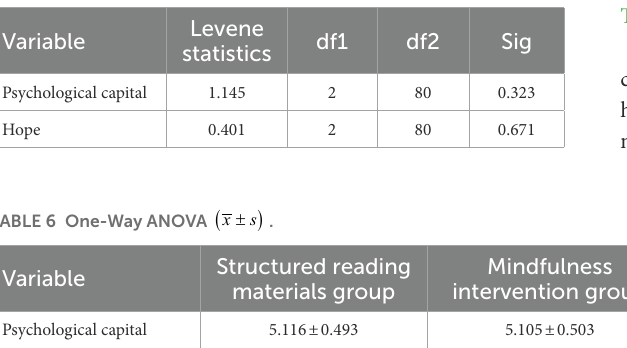
TABLE 5 Homogeneity of variance test.